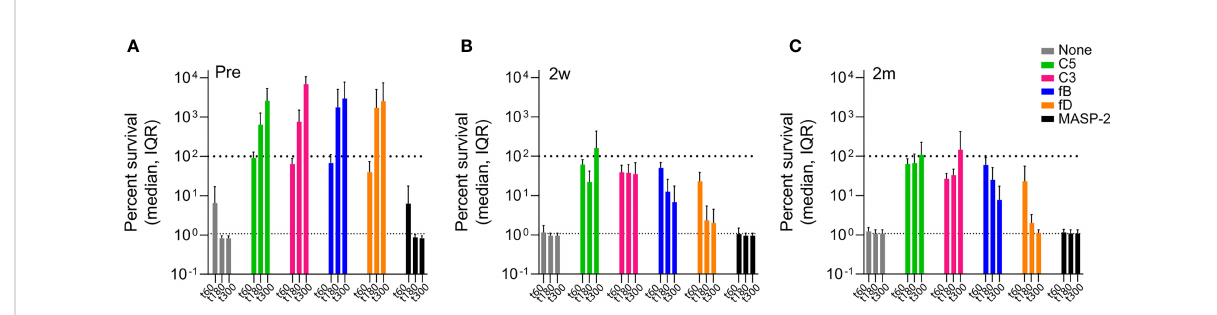
FIGURE 6 Effect of complement inhibitors on killing of Hib isolate 23393 in reconstituted whole blood before and after ActHIB vaccination. Cumulated data for all study subjects are shown. The upper dashed lines corresponds to the amount of bacteria inoculated at time 0 (100% survival), while the lower dashed line represents the lower detection limit (< 100 CFU/mL) for bacterial quanti fi cation. Bacterial killing was assessed using PBS- washed EDTA-anticoagulated blood cells reconstituted with undiluted active serum, comparing serum taken before (A) , 2 weeks (B) and 2 months (C) after ActHIB vaccination. CFUs were quanti fi ed 1, 3 and 5 hours after inoculation, represented by the 3 bars. The following inhibitor concentration were analyzed: fB inhibitor (iptacopan): 25 µM; fD inhibitor (CMS487): 25 µM; C3 inhibitor (CP-40): 50 µg/mL; anti-C5 mAb (tesidolumab): 50 µg/mL; and anti-MASP-2 mAb: 50